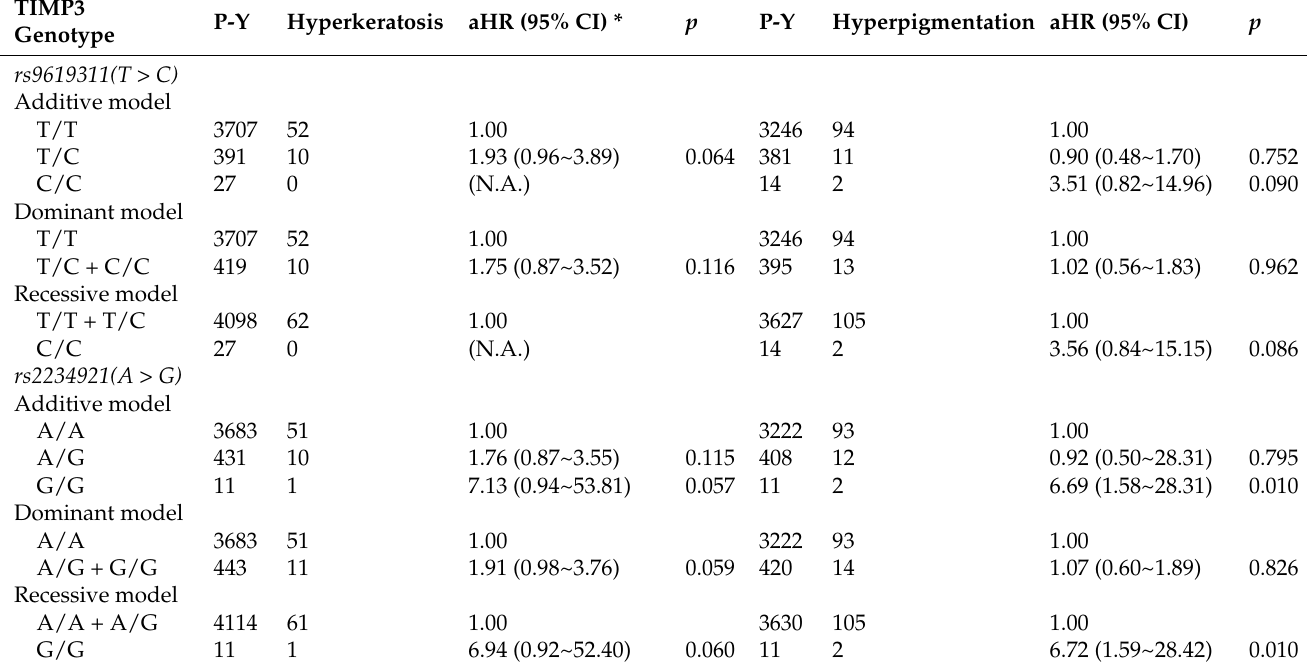
Table 5. Hazard ratios (HRs) of skin lesions (hyperkeratosis and hyperpigmentation) in relation to the TIMP3 rs9619311 and rs2234921